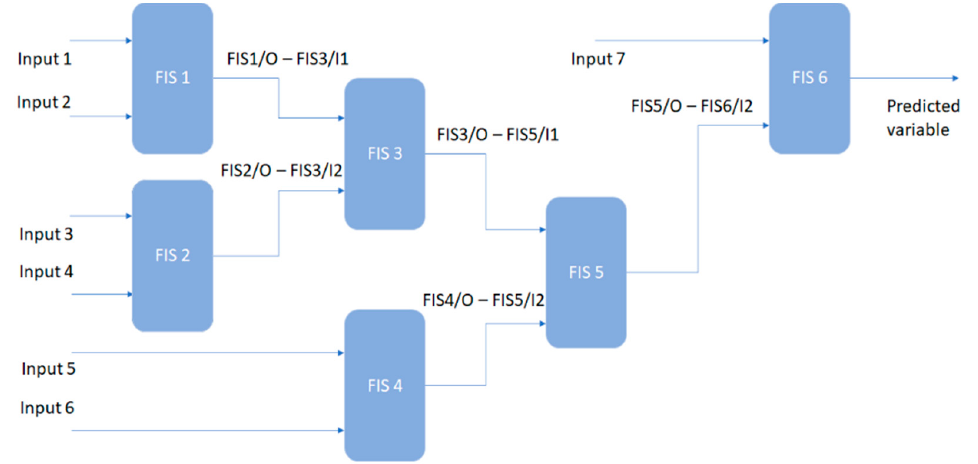
Figure 6. General architecture of DFIST model.